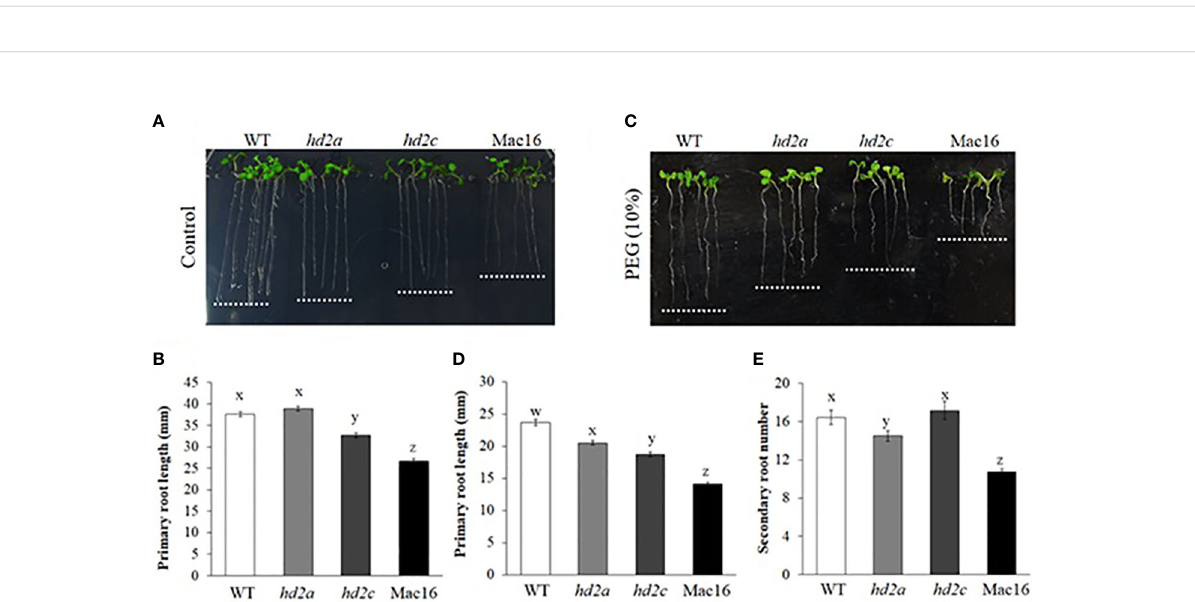
FIGURE 7 Root growth in hd2 mutants under control and osmotic stress. Images of root growth in 10-day old WT, hd2a , hd2c , and Mac16 seedlings under control (A) and PEG-6000 (10%) conditions (C) . (B, D) Primary root lengths measured in 10-day old WT, hd2a , hd2c , and Mac16 seedlings under control (B) and PEG-6000 (D) conditions. (E) Secondary root number counted in 10-day old WT, hd2a , hd2c , and Mac16 seedlings under control conditions. Data shown are means ± standard errors (n = 60). Three independent experiments were performed in this test. In each experiment, 20 seedlings of each genotype were used to measure the primary root lengths or secondary root numbers. The signi fi cance of the differences between different genotypes was determined by one-way ANOVA followed by post-hoc Tukey ’ s HSD tests. Lowercase letters indicate signi fi cant differences (p <